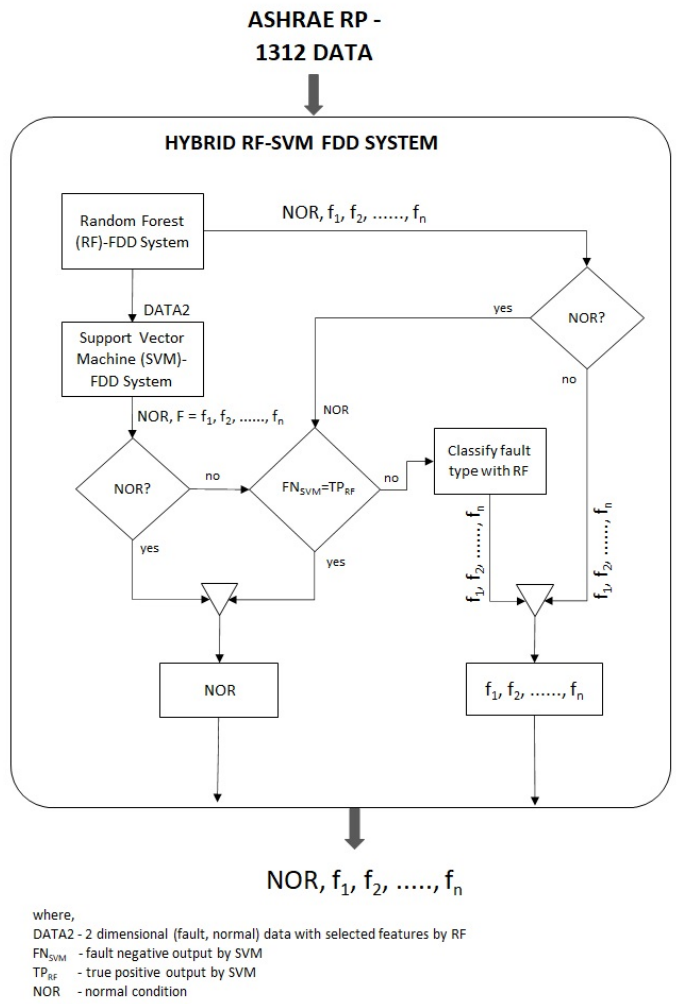
Figure 2. The overview of proposed HRF–SVM FDD